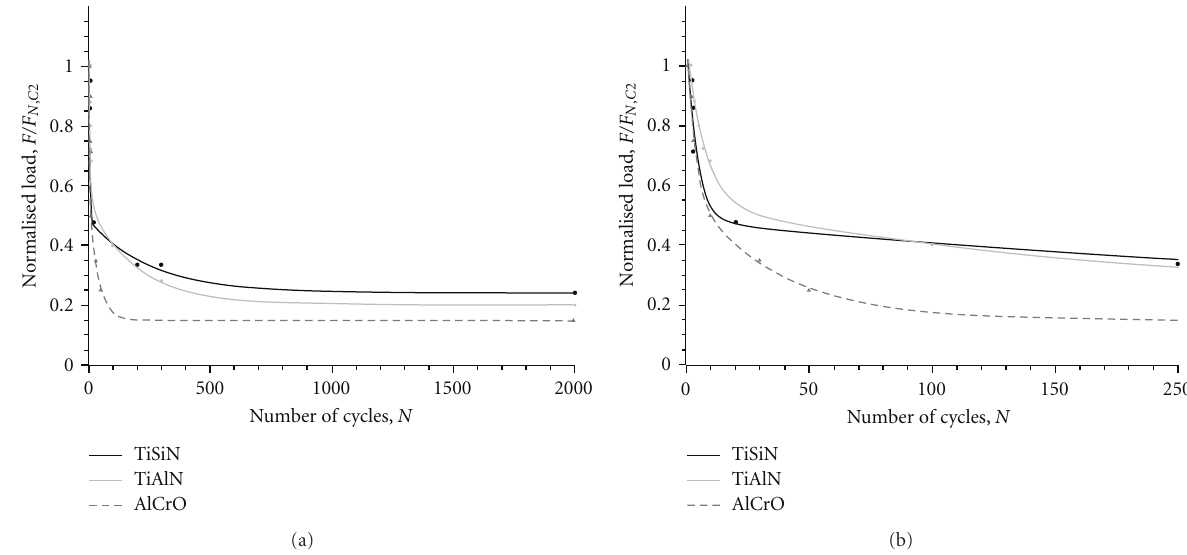
Figure 5: Normalised load-number of cycles curves for the coatings investigated showing the normalised normal load for continuous interfacial